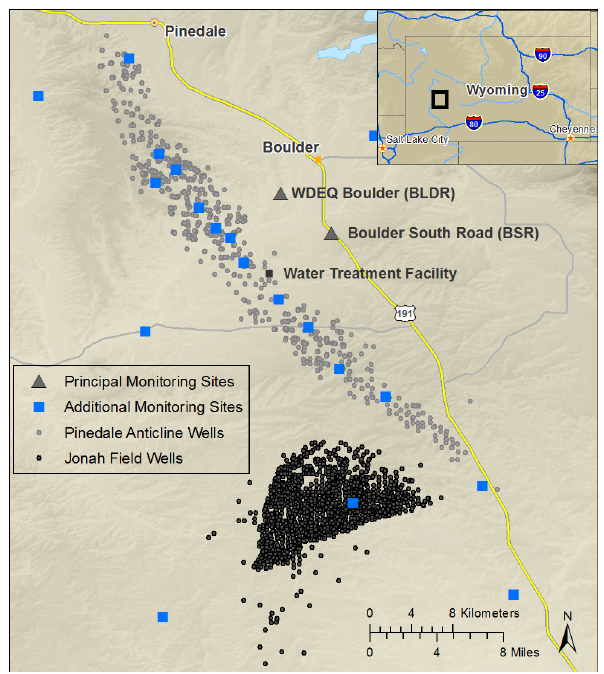
Figure 1. Map of study area including principal monitoring sites and locations of oil and natural gas wells within the Jonah Field and the Pinedale